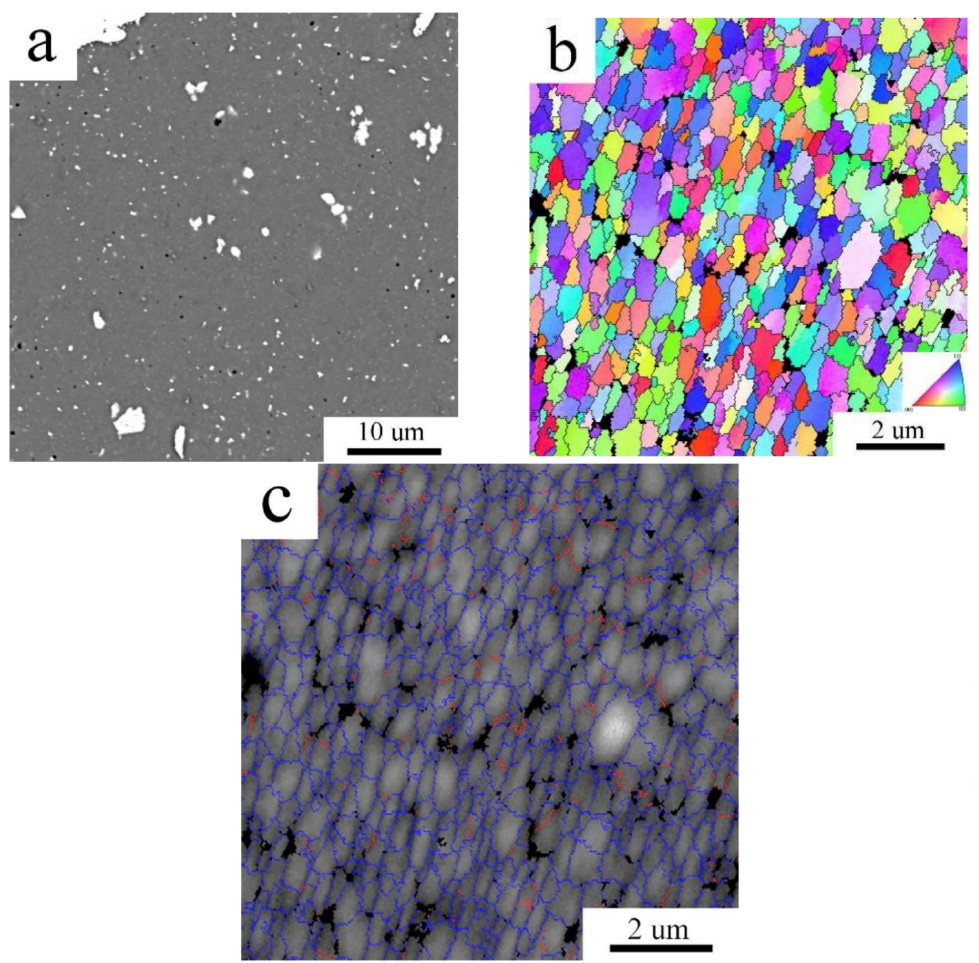
Figure 13. The microstructure of the Al7075_MC_HT compact (annealed 425 ◦ C/1 h): ( a ) BSE contrast image; ( b ) EBSD inverse pole figure; ( c ) distribution of grain boundaries, boundaries with misorientation angles above 15 ◦ in blue, boundaries between 5 ◦ and 15 ◦ in